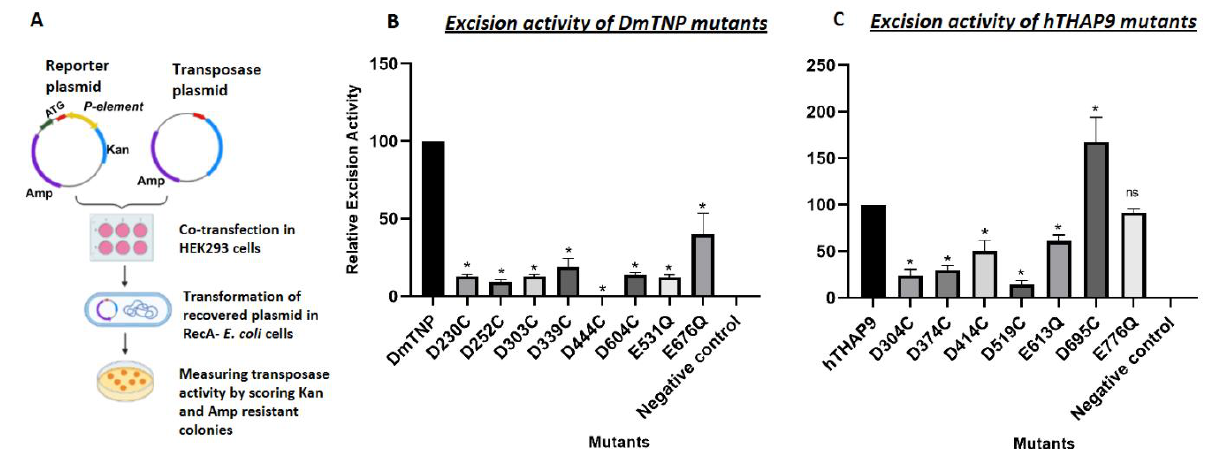
Figure 5. Conserved acidic residues within the catalytic triad and signature string of DmTNP and hTHAP9 are important for DNA excision. ( A ) Schematic of transposon excision assay. Relative excision activities of ( B ) DmTNP mutants (compared to wild type DmTNP) and ( C ) hTHAP9 mutants (compared to wild type hTHAP9). Negative control (pBluescript empty vector). All the values are represented as a mean of four independent experiments ( ± SEM, n = 4) p value < 0.05, * ( p < 0.033), ns ( p <